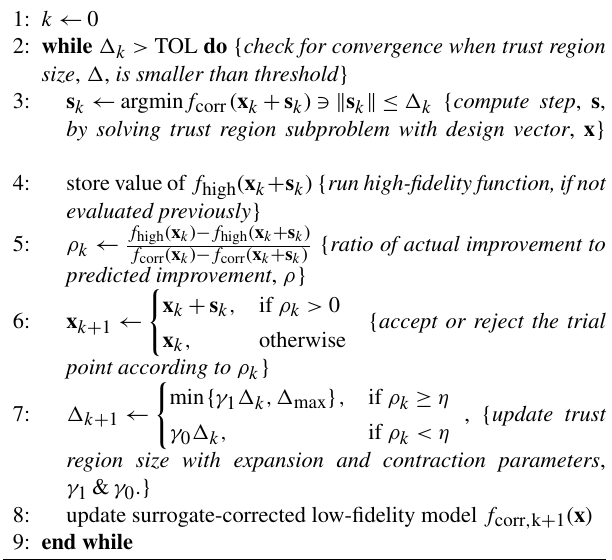
Algorithm 1 An updated multifidelity trust-region algorithm adapted from March and Willcox